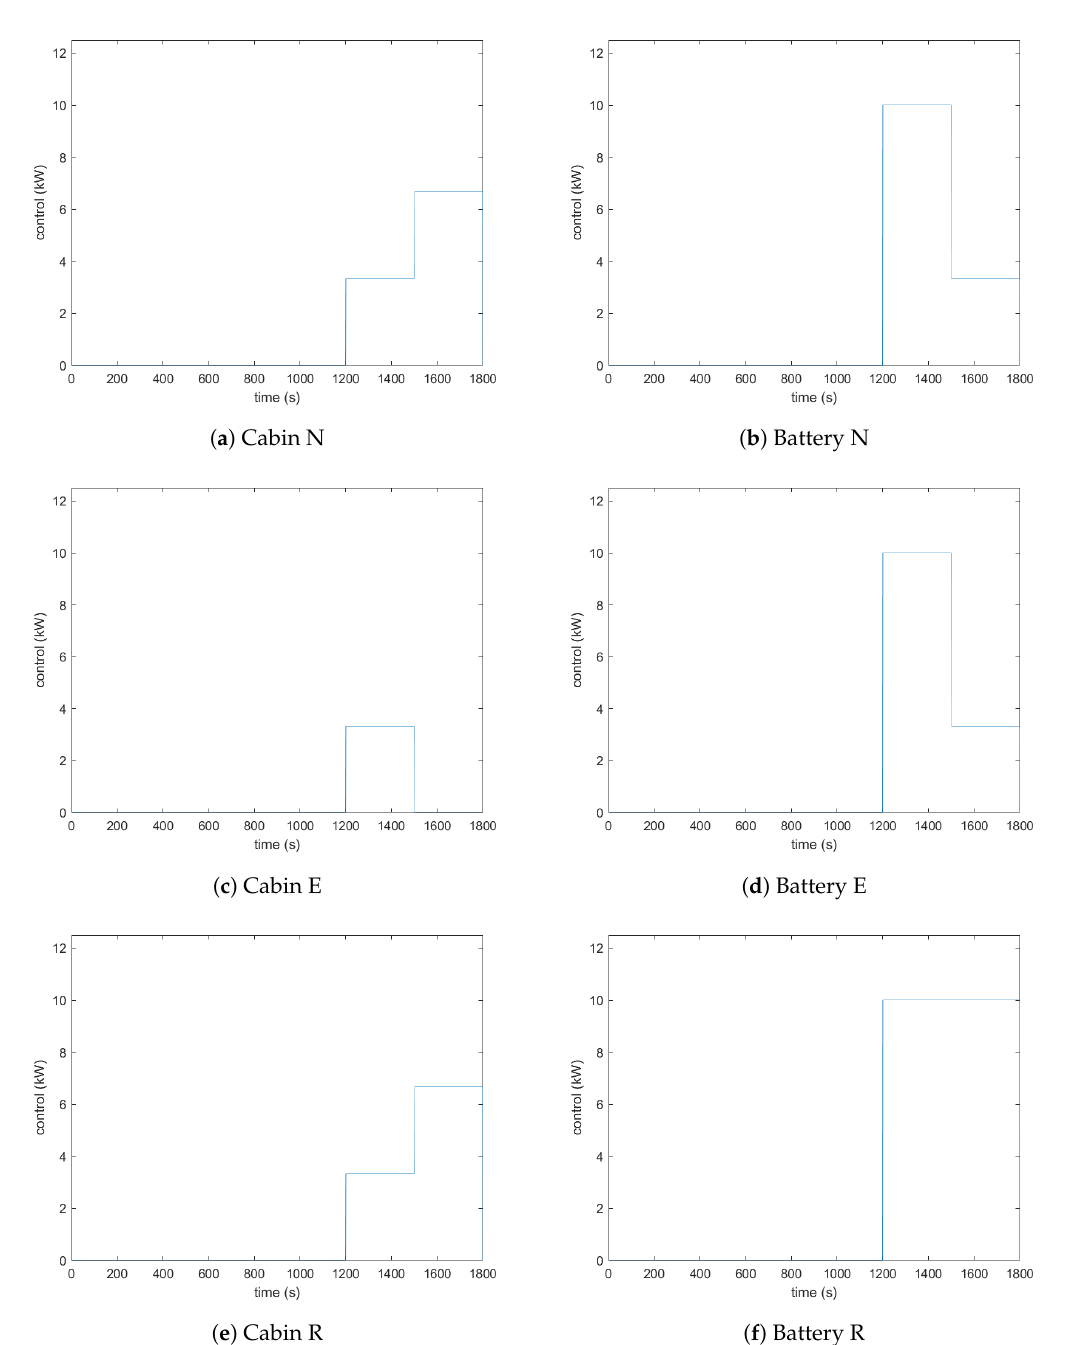
Figure 16. The optimal battery heating strategies generated according to the 6 weightings designed to produce a strategy which favours the cabin or the battery at − 7 ◦